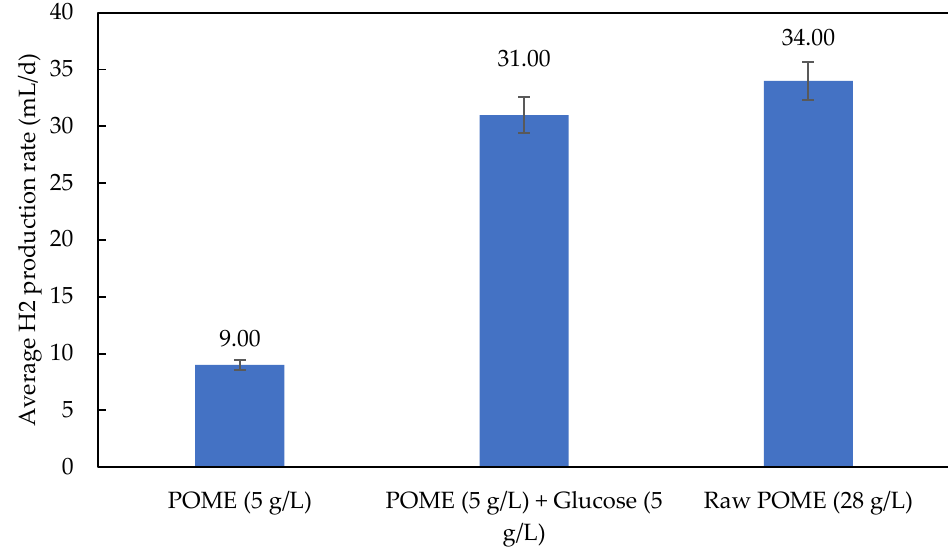
Figure 6. Effect of various POME concentrations on biohydrogen production rate. The cultures were grown at pH 5.5, 37 ◦ C, 150 rpm, and 24 h reaction time. Results display error bars with a 5% value (95% confidence level).